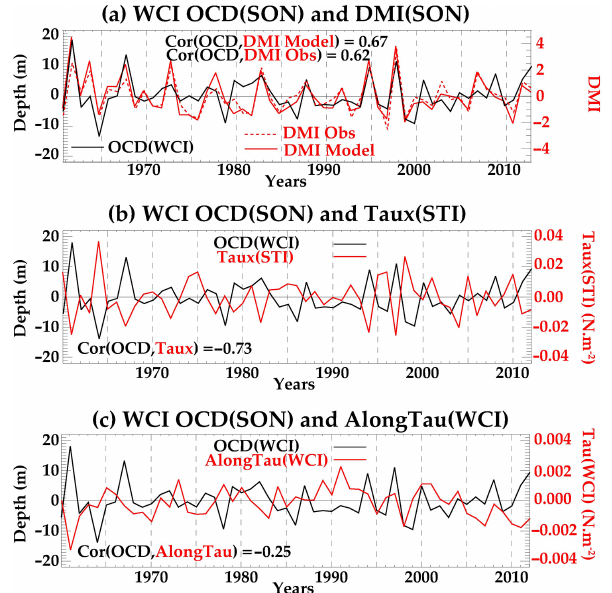
Figure 12. Scatterplot of the fall interannual anomalies of modeled WCI oxycline depth against modeled DMI. Red and blue crosses, respectively, indicate positive and negative IOD events (defined as events when DMI exceeds 1 standard deviation). Years of anoxic events reported by Naqvi et al. (2009) are marked as stars, along with the corresponding